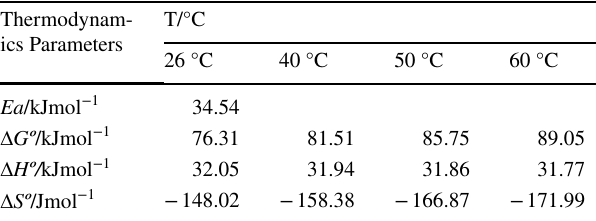
Table 6 Thermodynamics parameters of Synozol Blue dye